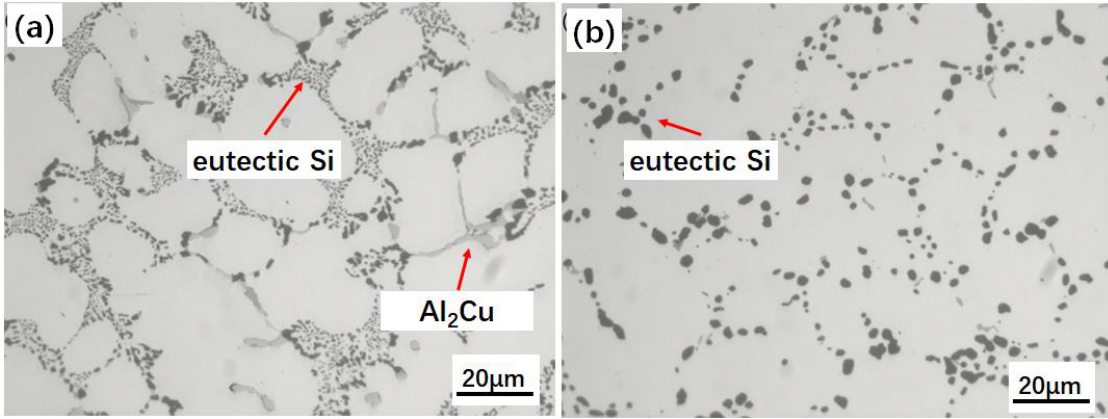
Figure 7. Microstructures of the Al-Si-Cu-Mg 319 alloy subjected different treatments: ( a ) F and ( b ) SHT.